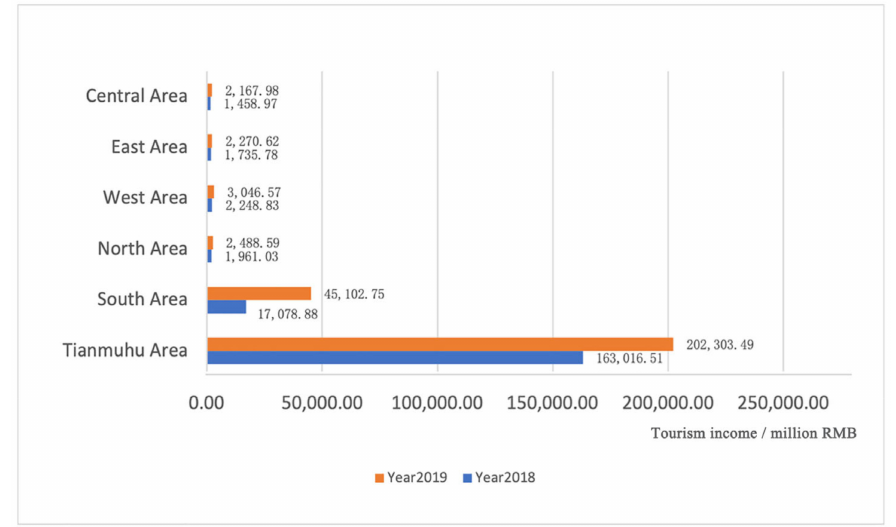
Figure 14. Regional distribution of tourism flow